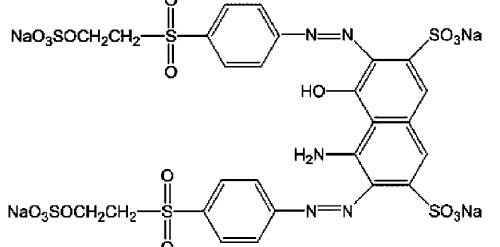
Figure 1. Reactive black 5 structure. RB5 class: diazo; reactive group: sulfatoethylsulfone; natural pH: 5.8; λ (visible): 591 nm; molecular weight: 991.8 g mol max